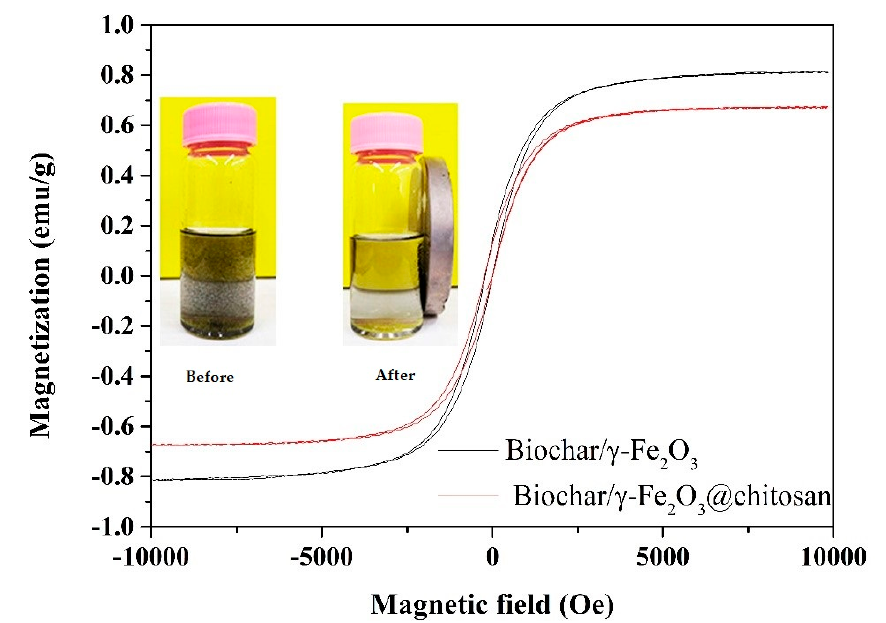
Figure 3. Vibrating-sample magnetometer (VSM) magnetization curves of the biochar/ γ -Fe 2 O 3 (black curve) and biochar/ γ -Fe 2 O 3 @chitosan (red curve). The insets show the state of the biochar/ γ - Fe 2 O 3 @chitosan before and after being recovered by a magnet.